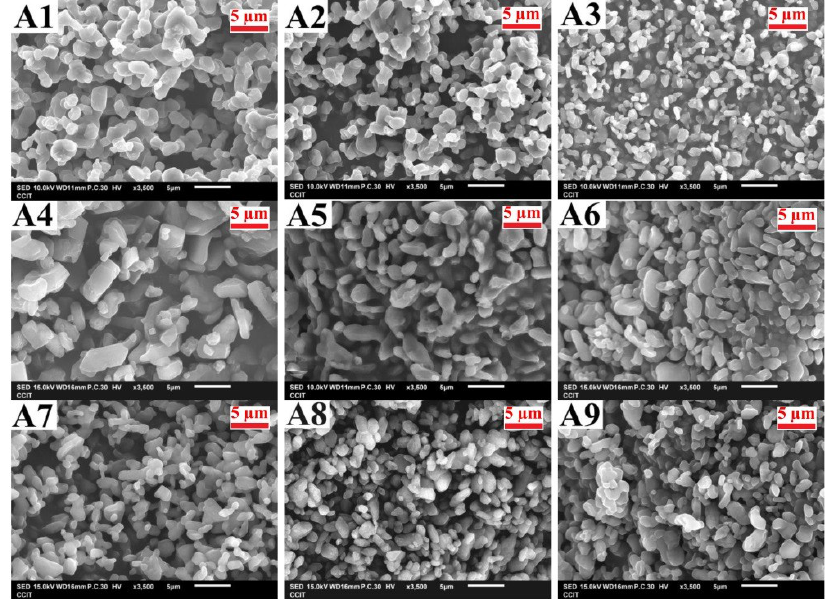
Figure 3. SEM images of micronized p-TSA particles under nine different experimental conditions.